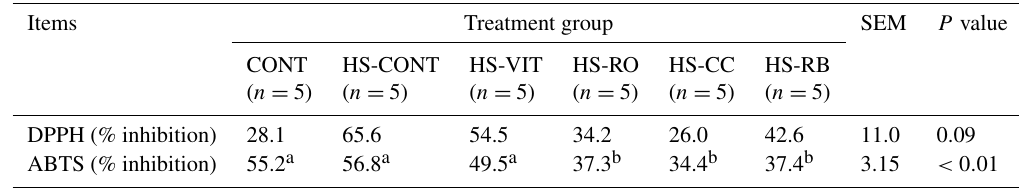
Table 6. Effect of dietary supplementation on the percentage inhibition values of serum towards DPPH or ABTS free radicals in broilers reared under normal or HS conditions. Treatment